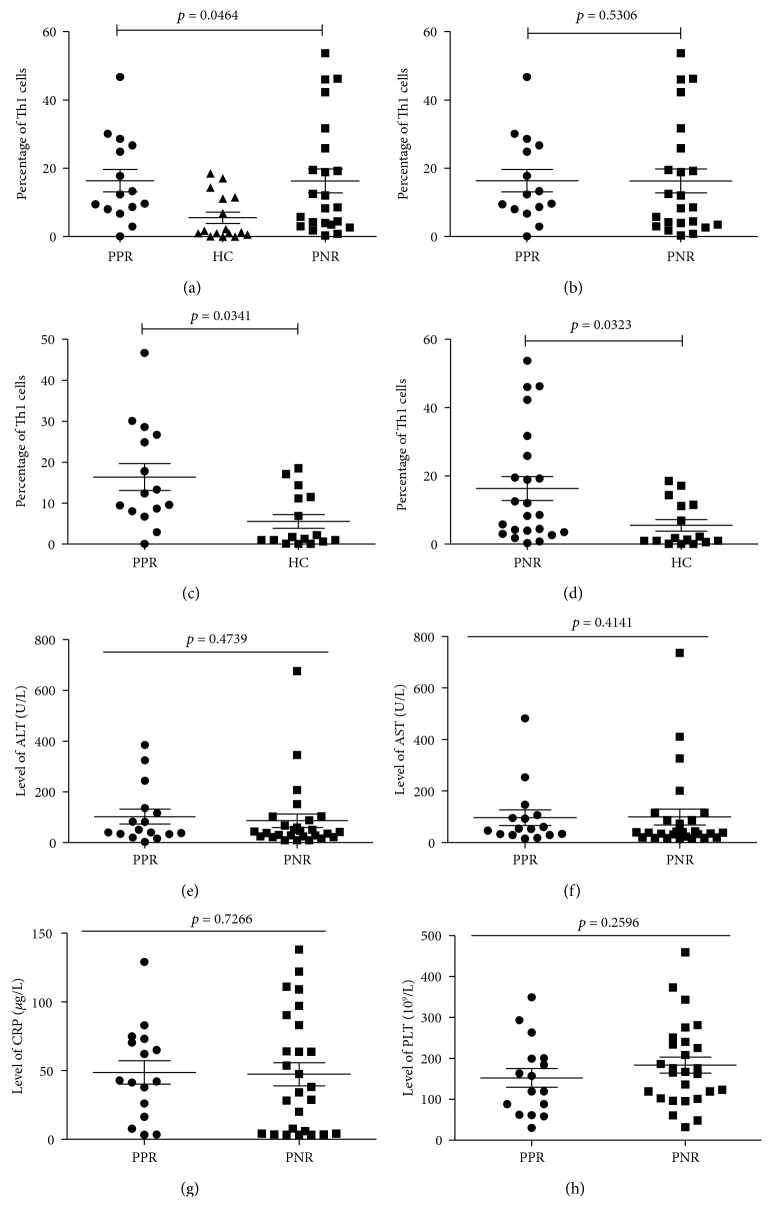
Percentages of serum Th1 cells and the clinical parameters of each group with different blood culture results. (a) Data were collected by flow cytometry and assessed with the one-way analysis of variance (ANOVA). Data analysis shows statistically significant differences in the percentages of Th1 in the different groups (p < 0.05). (b) Data analysis shows no statistical difference between patients with positive culture result (PPR) and patients with negative culture result (PNR) groups (p > 0.05). (c) Data analysis shows a statistically significant difference between PPR and HC groups (p < 0.05). (d) Data analysis showed a statistically significant difference between PNR and HC groups (p < 0.05). (e–h) The clinical parameters (ALT, AST, CRP, and PLT) in both groups with different blood culture results. No significant differences in any of the clinical parameters were detected between the two groups. Abbreviations: PPR: patients with positive culture result; PNR: patients with negative culture result; HC: healthy controls.